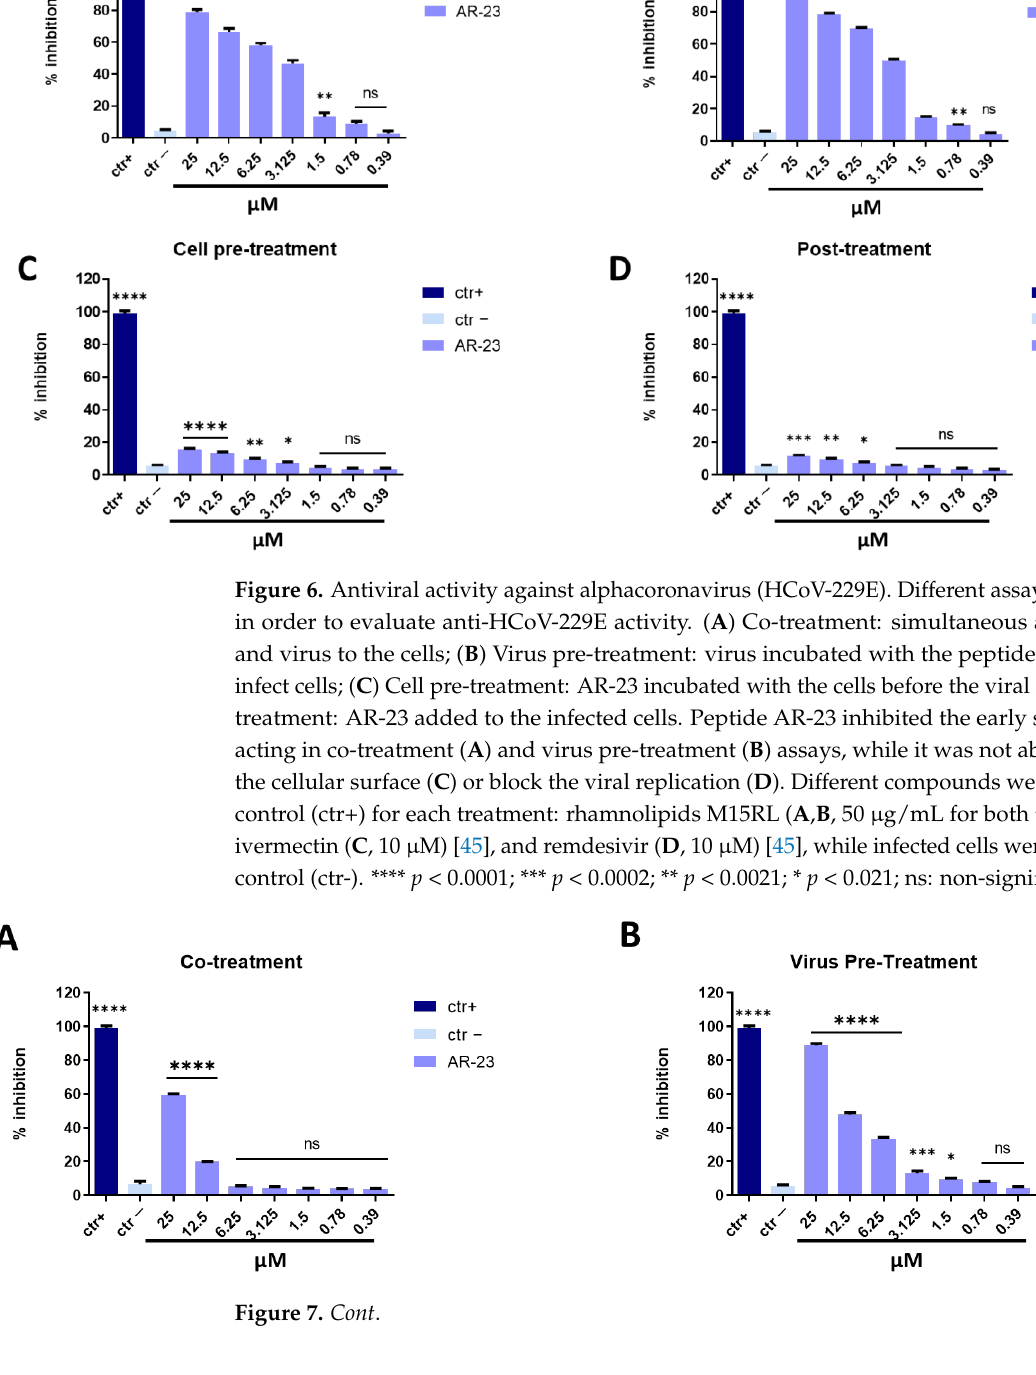
Figure 7. Antiviral activity against betacoronavirus (SARS-CoV-2). Different assays were per- formed in order to evaluate anti-SARS-CoV-2 activity. ( A ) Co-treatment: simultaneous addition of AR-23 and virus to the cells; ( B ) Virus pre-treatment: virus incubated with the peptide, and then used to infect cells; ( C ) Cell pre-treatment: AR-23 incubated with the cells before the viral infection; ( D ) Post-treatment: AR-23 added to the infected cells. Peptide AR-23 inhibited the early stages of infection, acting in co-treatment ( A ) and virus pre-treatment ( B ) assays, while it was not able to interact with the cellular surface ( C ) or block the viral replication ( D ). Different compounds were used as positive control (ctr+) for each treatment: rhamnolipids M15RL ( A , B , 50 μ g/mL for both the assays) [43] , ivermectin ( C , 10 μ M) [45] , and remdesivir ( D , 10 μ M) [45] , while infected cells were used as negative control (ctr-). **** p < 0.0001; *** p < 0.0002; ** p < 0.0021; * p < 0.021; ns: non-significant. AR- 23 showed 60% of inhibition at 25 μM in co -treatment experiments and 50% at 12.5 μM in virus pre -treatment assay against SARS-CoV-2, while it was inactive in cell pre-treatment and post-treatment conditions (Figure 7). Overall, these results suggested that the antiviral activity of AR-23 is generally directed toward the early stages of viral entry. Picornaviridae Poliovirus type 1 (PV-1), an enterovirus belonging to the Picornaviridae family, was used as a viral model without envelope with a single-stranded, positive-sense RNA ge- nome. The antiviral activity of AR-23 against PV-1 was assayed in the same conditions used for other viruses previously described. As reported in Figure 8, AR-23 was not able to show any relevant activity against PV-1. Our conclusions are that the main target for AR-23 is the lipidic membrane of enveloped viruses.